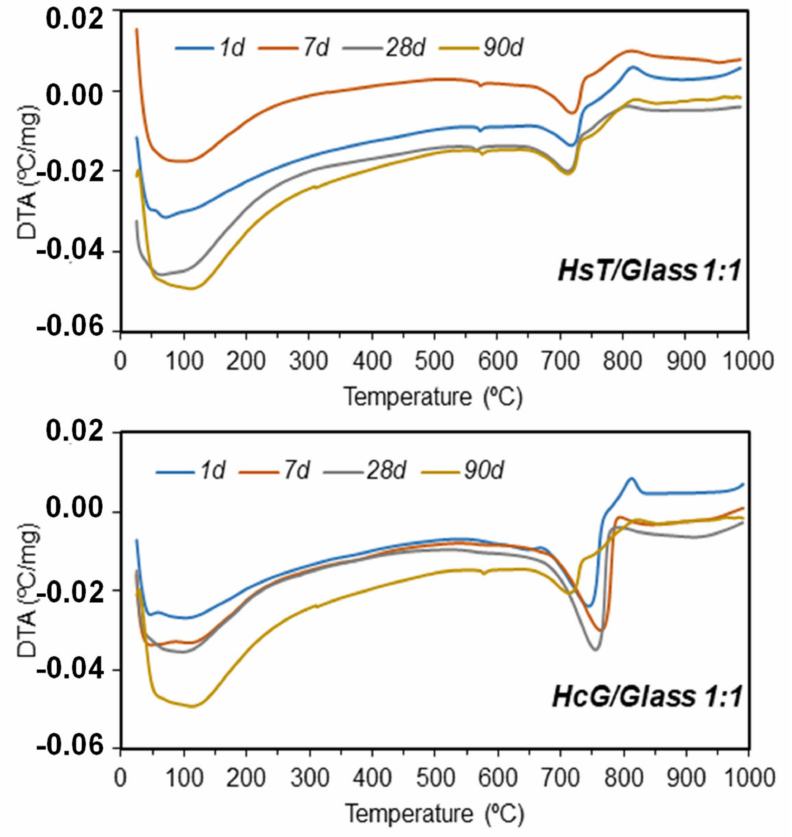
Figure 8. DTA curves for the pozzolan 1:1 mix up until 90 days of reaction